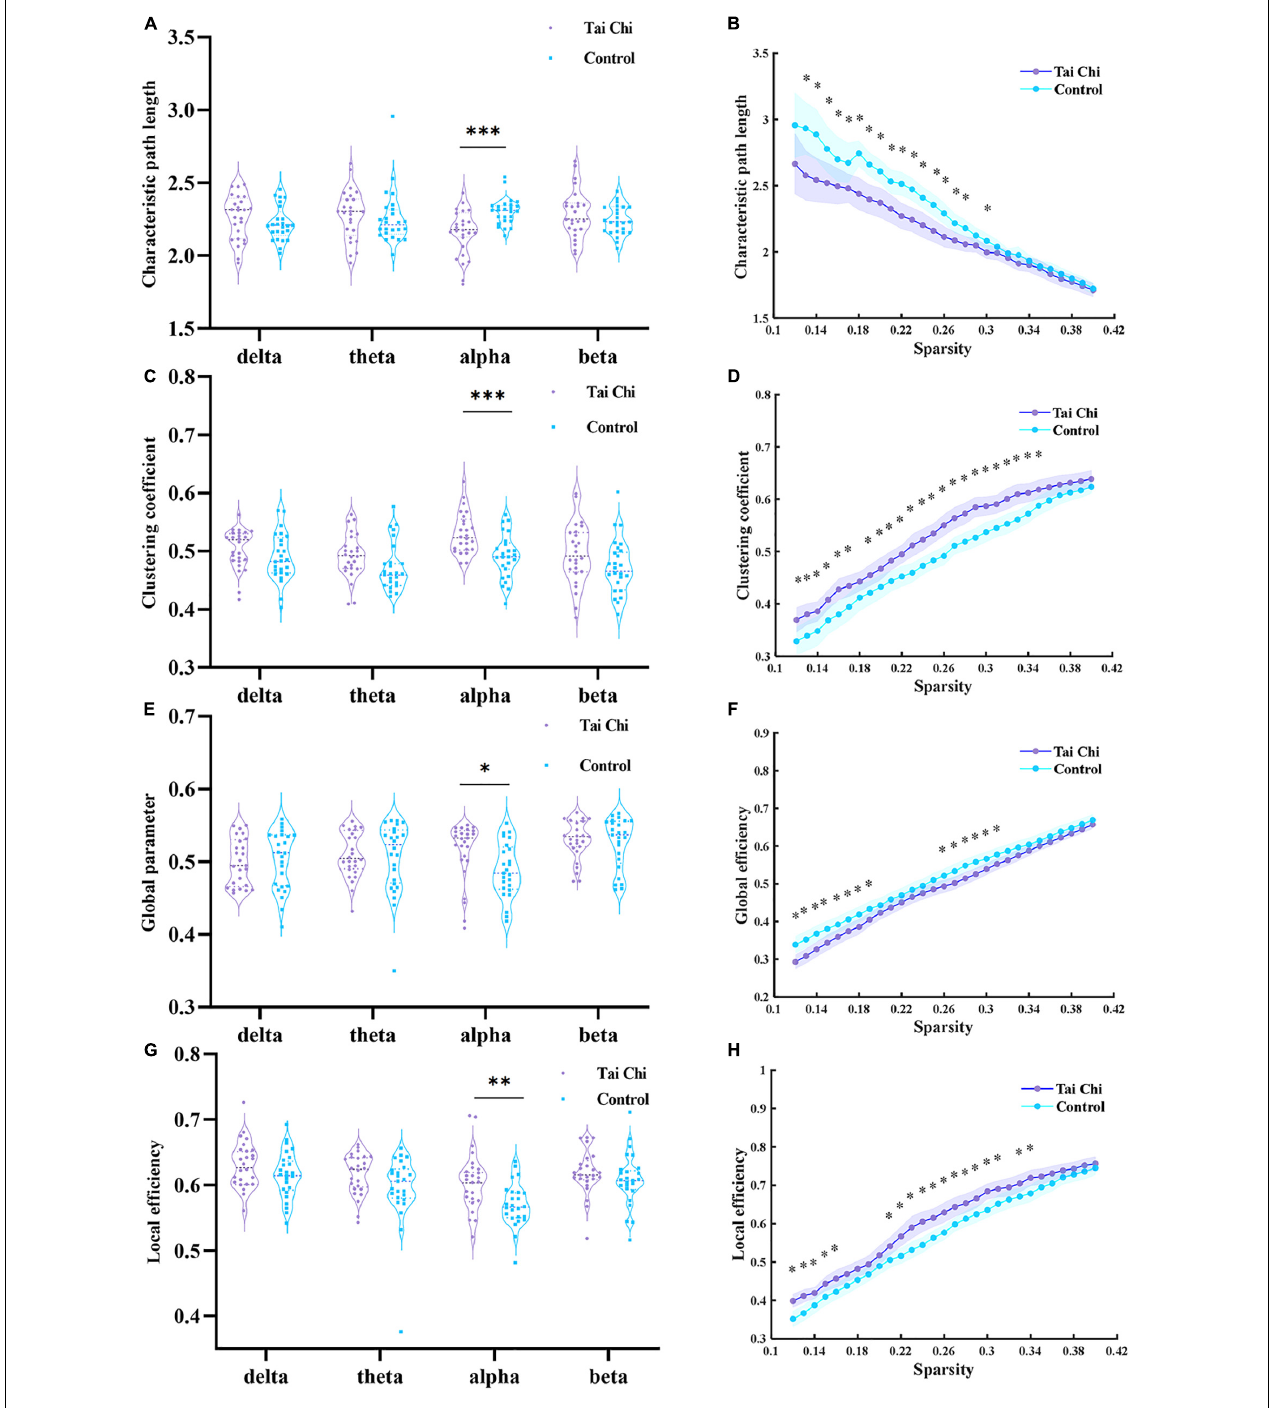
FIGURE 5 | Panels (A,C,E,G) showed the inter-group differences of clustering coefficient, characteristic path length, global efficiency and local efficiency within the selected sparsity threshold range at each frequency band, respectively. Panels (B,D,F,H) represented the inter-group differences of clustering coefficient, characteristic path length, global efficiency, and local efficiency of two groups of subjects under each single sparsity threshold at alpha frequency band, respectively. The purple and blue shading represented 95% confidence intervals of the TC group and the control group, ∗ indicated significant difference between groups, p < 0.05, ∗∗ indicated significant difference between groups, p < 0.01; and ∗∗∗ indicated a very significant difference between groups, p <